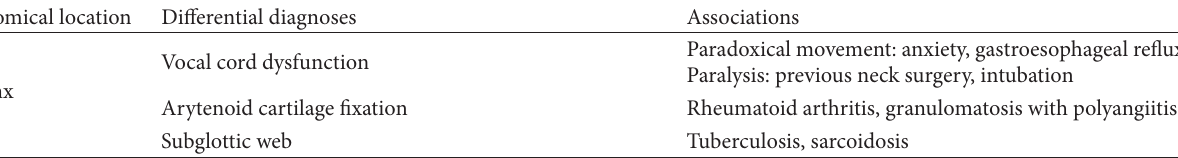
Table 1: Major differentials for adult-onset asthma and their